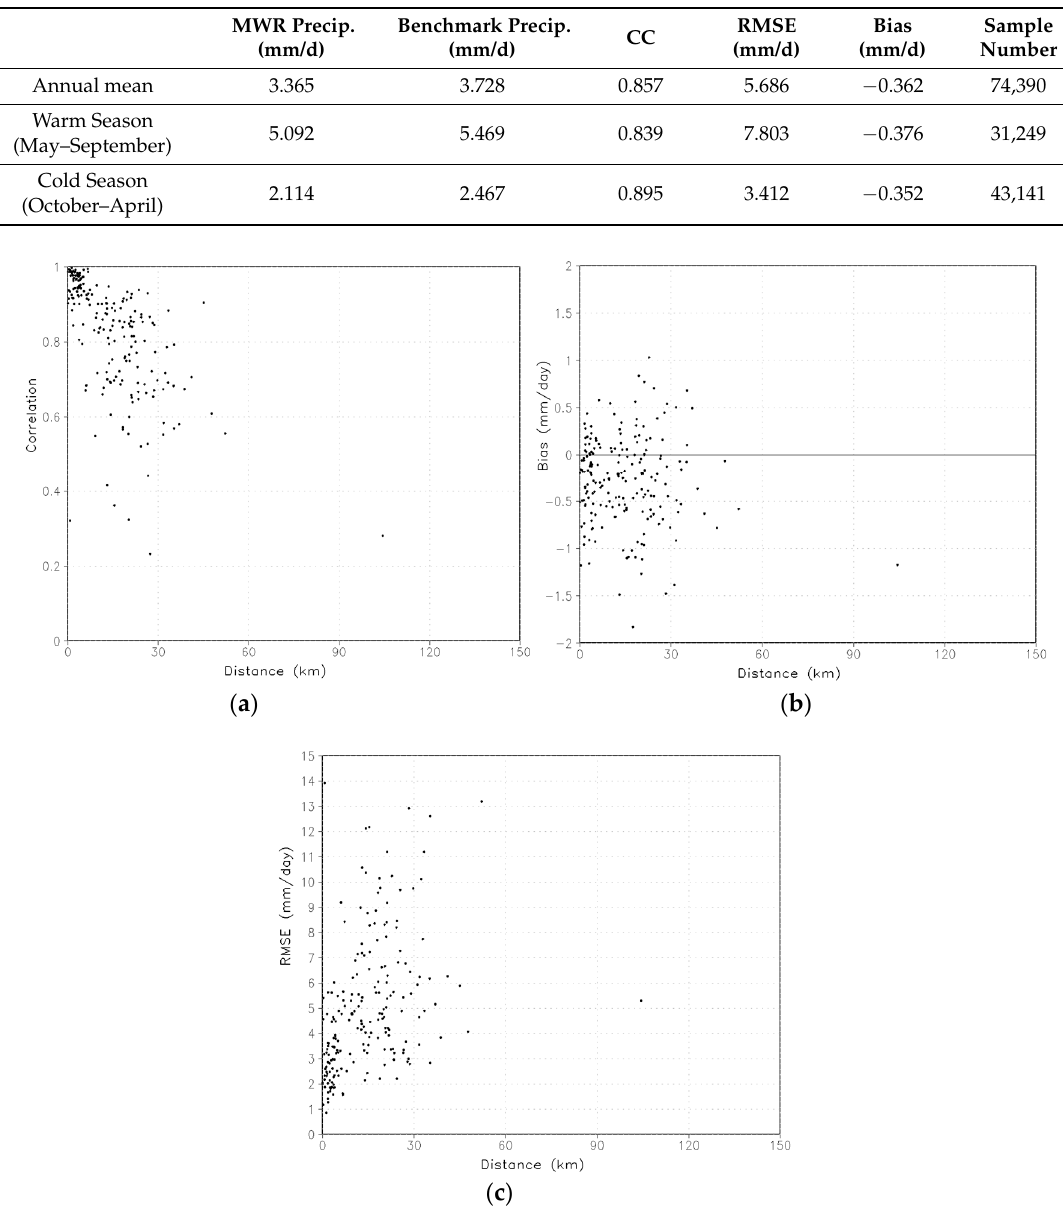
Table 1. Statistical metrics for daily precipitation between the hydrological station (MWR Precip.) and its nearest benchmark station (Benchmark Precip.) at three time scales.